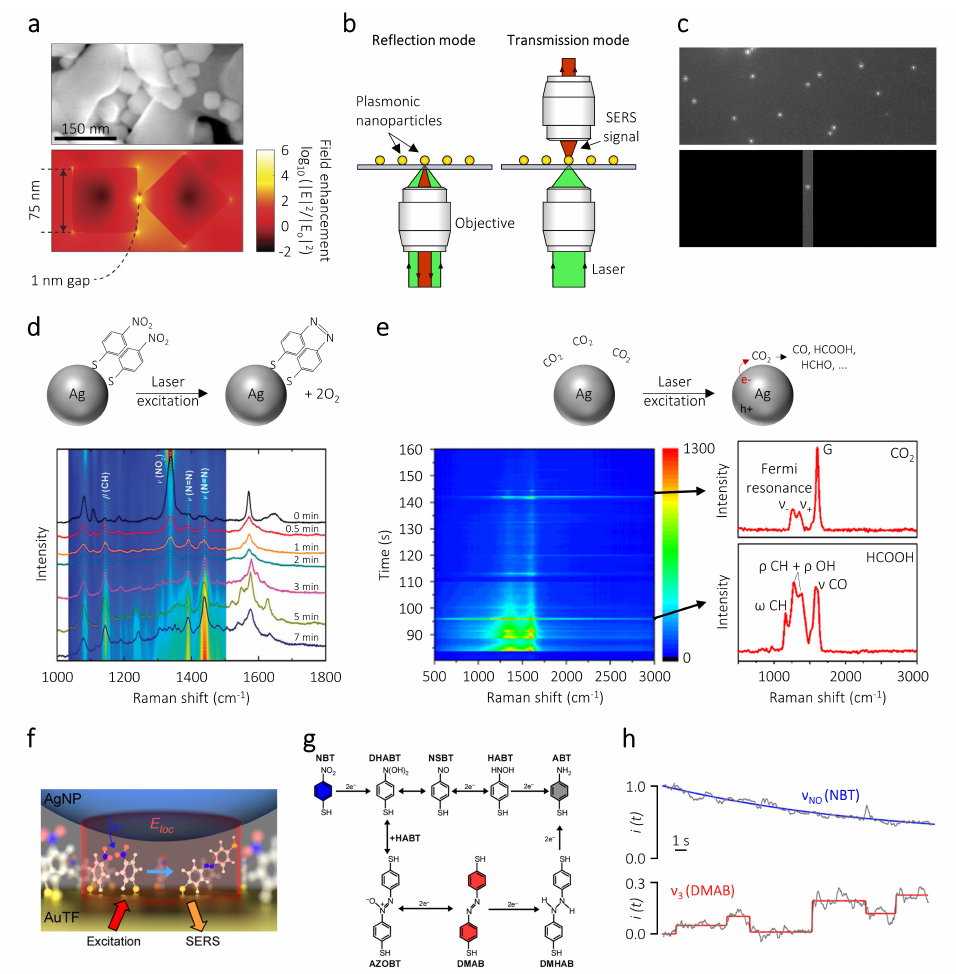
Figure 2. Surface-enhanced Raman spectroscopy (SERS). ( a ) ( top ) Scanning electron micrograph of silver nanocubes supported on alumina particles. The cubes arrange randomly, thereby generating geometries that can provide high electric fields. ( bottom ) Finite-difference time-domain simulation of the spatial distribution of the electric fields of 75 nm Ag nanocubes separated by 1 nm gap. The calculation is performed at the resonance wavelength of 500 nm. ( b ) Schematic illustration of SERS measurements over single nanoparticles in reflection and transmission mode. ( c ) ( top ) Grayscale dark-field image of several single plasmonic nanoparticles deposited on a transparent substrate. ( bottom ) Dark-field image of an individual nanoparticle obtained by closing the parallel slit located at the entrance of the monochromator, corresponding to the image plane outside the microscope. ( d ) ( top ) Schematic representation of the plasmon-driven reduction of p-nitrobenzenethiol (NBT) to p,p’-dimercaptoazobenzene (DMAB). ( bottom ) Time-resolved SERS measurement of the NBT reduction. ( e ) ( top ) Schematic representation of the plasmon-driven reduction of CO 2 . ( bottom ) Time-resolved SERS measurement indicating the intermittent nature of the signals from the physisorbed CO 2 reactant and the catalytic product HCOOH. ( f ) Artistic representation of the nanoparticle on mirror geometry, wherein NBT molecules are sandwiched between a Ag nanoparticle and a Au thin film. ( g ) Direct and indirect reaction pathways for the reduction of NBT to ABT. ( h ) Time-resolved SERS intensities of NBT and DMAB, along with the fit to a single exponential function (blue) and step function (red). Panel ( a ) is reproduced with permission of [69]. Copyright Nature Publishing Group, 2012. Panel ( d ) is reproduced with permission of [80]. Copyright Royal Society of Chemistry, 2013. Panel ( e ) is reproduced with permission of [93]. Copryright American Chemical Society, 2018. Panels ( f – h ) are reproduced with permission of [84]. Copyright American Chemical Society,